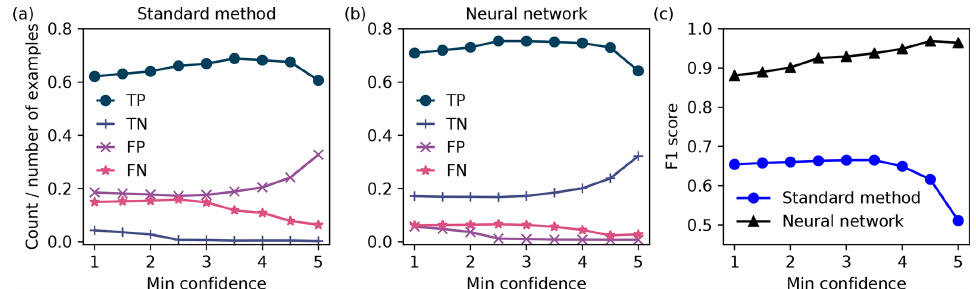
Figure 10. The computed number of true positives (TP, circle), true negatives (TN, plus), false positives (FP, cross), and false negatives (FN, star) versus the minimum confidence score, for the standard method and the neural network model in (a) and (b) , respectively. The F1 score versus confidence is shown in (c) for the standard method (circles) and the neural model (triangles). Examples having confidence lower than the minimum were not included in the calculation.